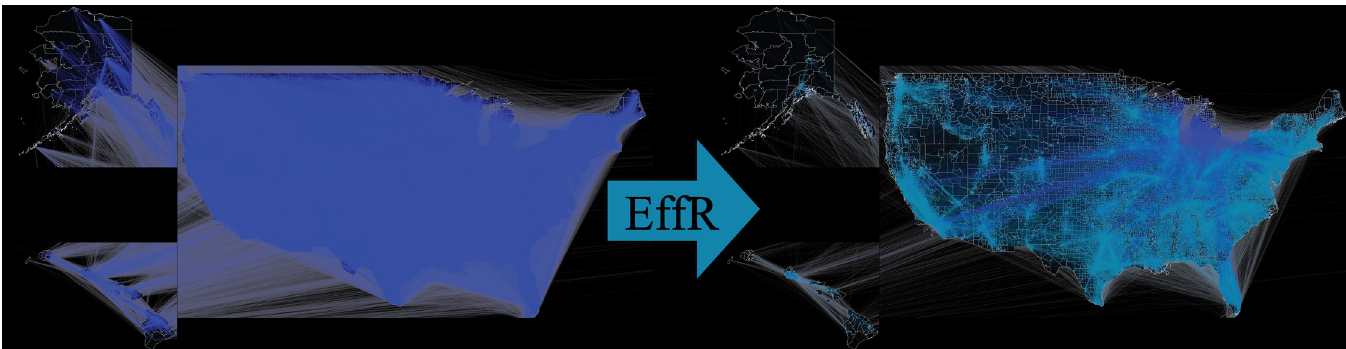
Fig 1. Sparsification of the U.S. mobility network. The U.S. mobility network, where nodes are census tracts and edges are weighted according to average human mobility between census tracts. On the left, the original network with about 26 million edges. On the right, a sparsified network based on effective resistance sampling with q = 0.1, preserving about 7% of the edges of the original. Heavier-weight edges are lighter in color on a logarithmic scale. Note the mixture of local and long-range links, and how sparsification reweights edges to be heavier in order to compensate for the decrease in